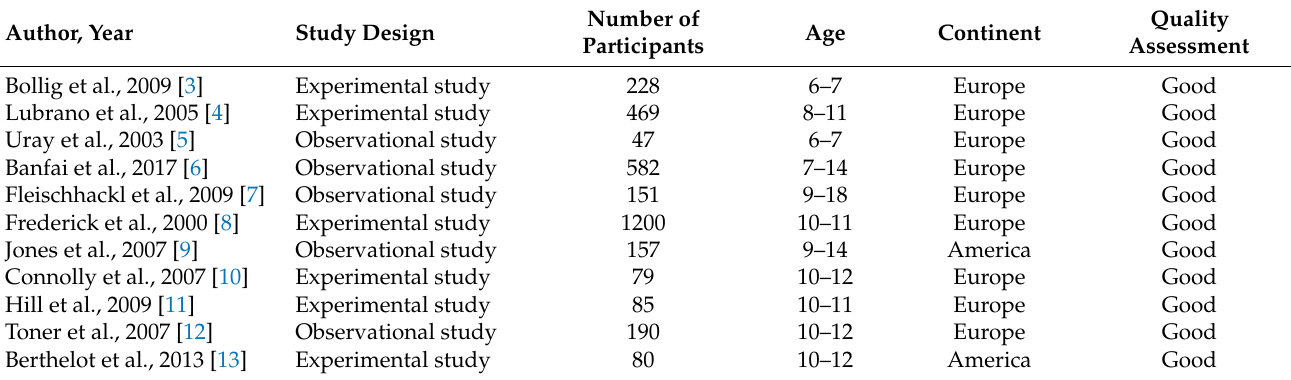
Table 1. Characteristics of included studies.